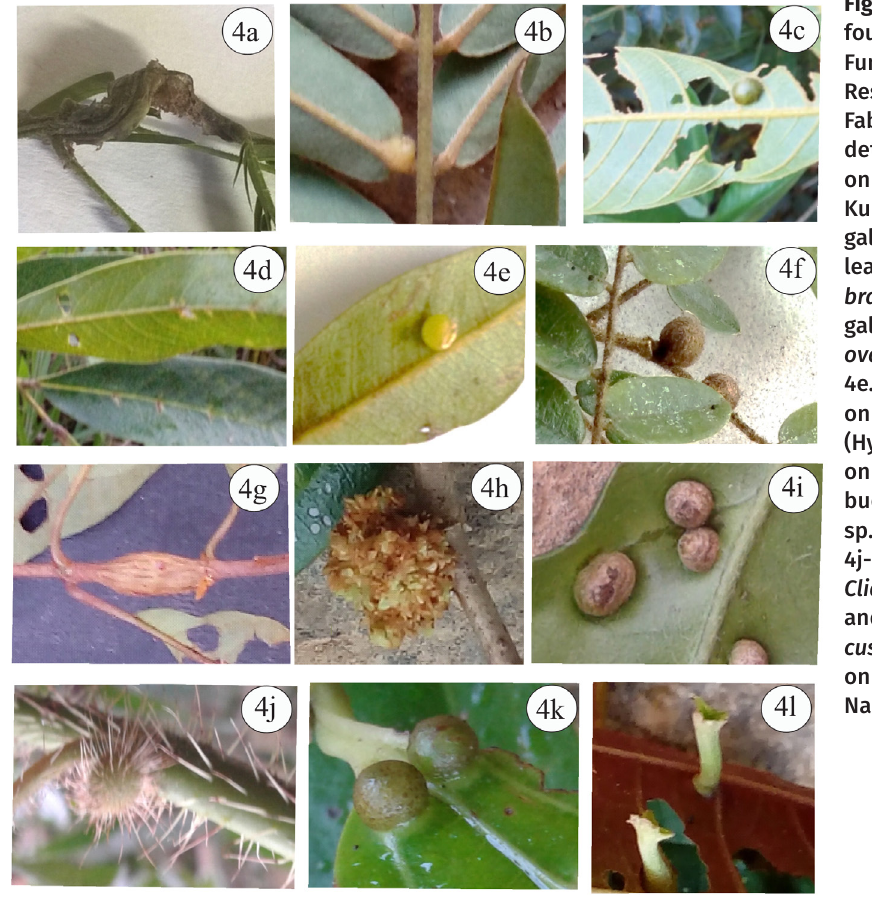
Gall (Fig. 4h): on bud, globoid, yellow, glabrous, one-chambered. Gall-inducer: Cecidomyiidae. A similar gall was reported by Urso-Guimarães et al. 2017 on S. parvifolia A. DC. in MS. Other galls were described on Strychnos spp. by Fernandes et al. 1997, Luz et al. 2012, and Costa & Araújo 2019 in MG, Saito & Urso- Guimarães 2012 in SP, and Araújo et al. 2015 in GO.